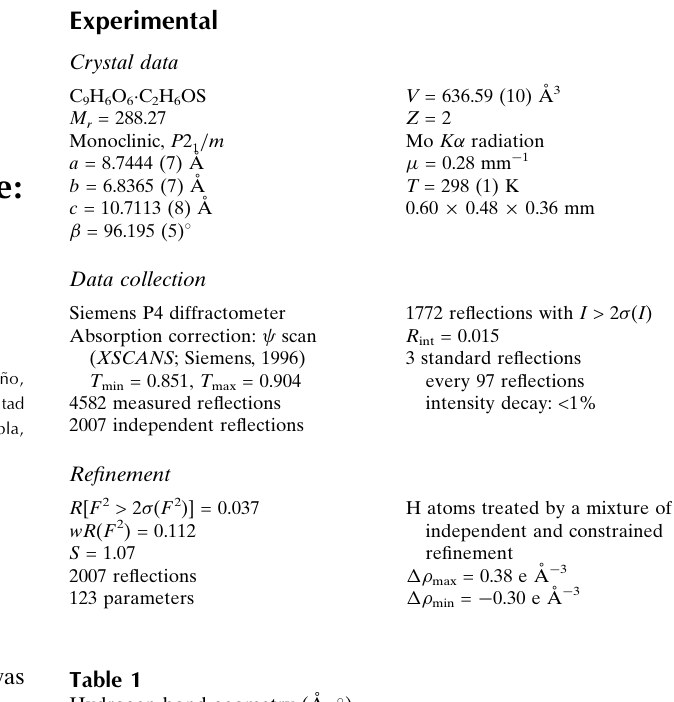
Hydrogen-bond geometry (A˚ , (cid:2)